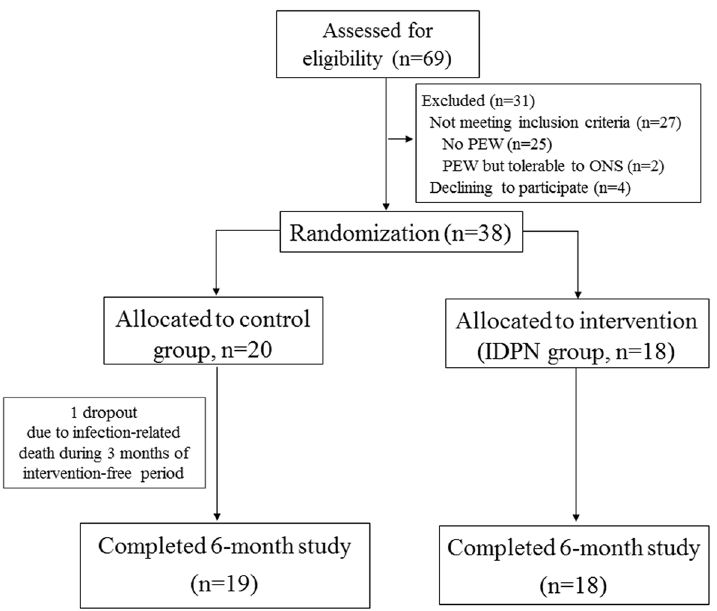
Figure 1. The CONSORT diagram of the